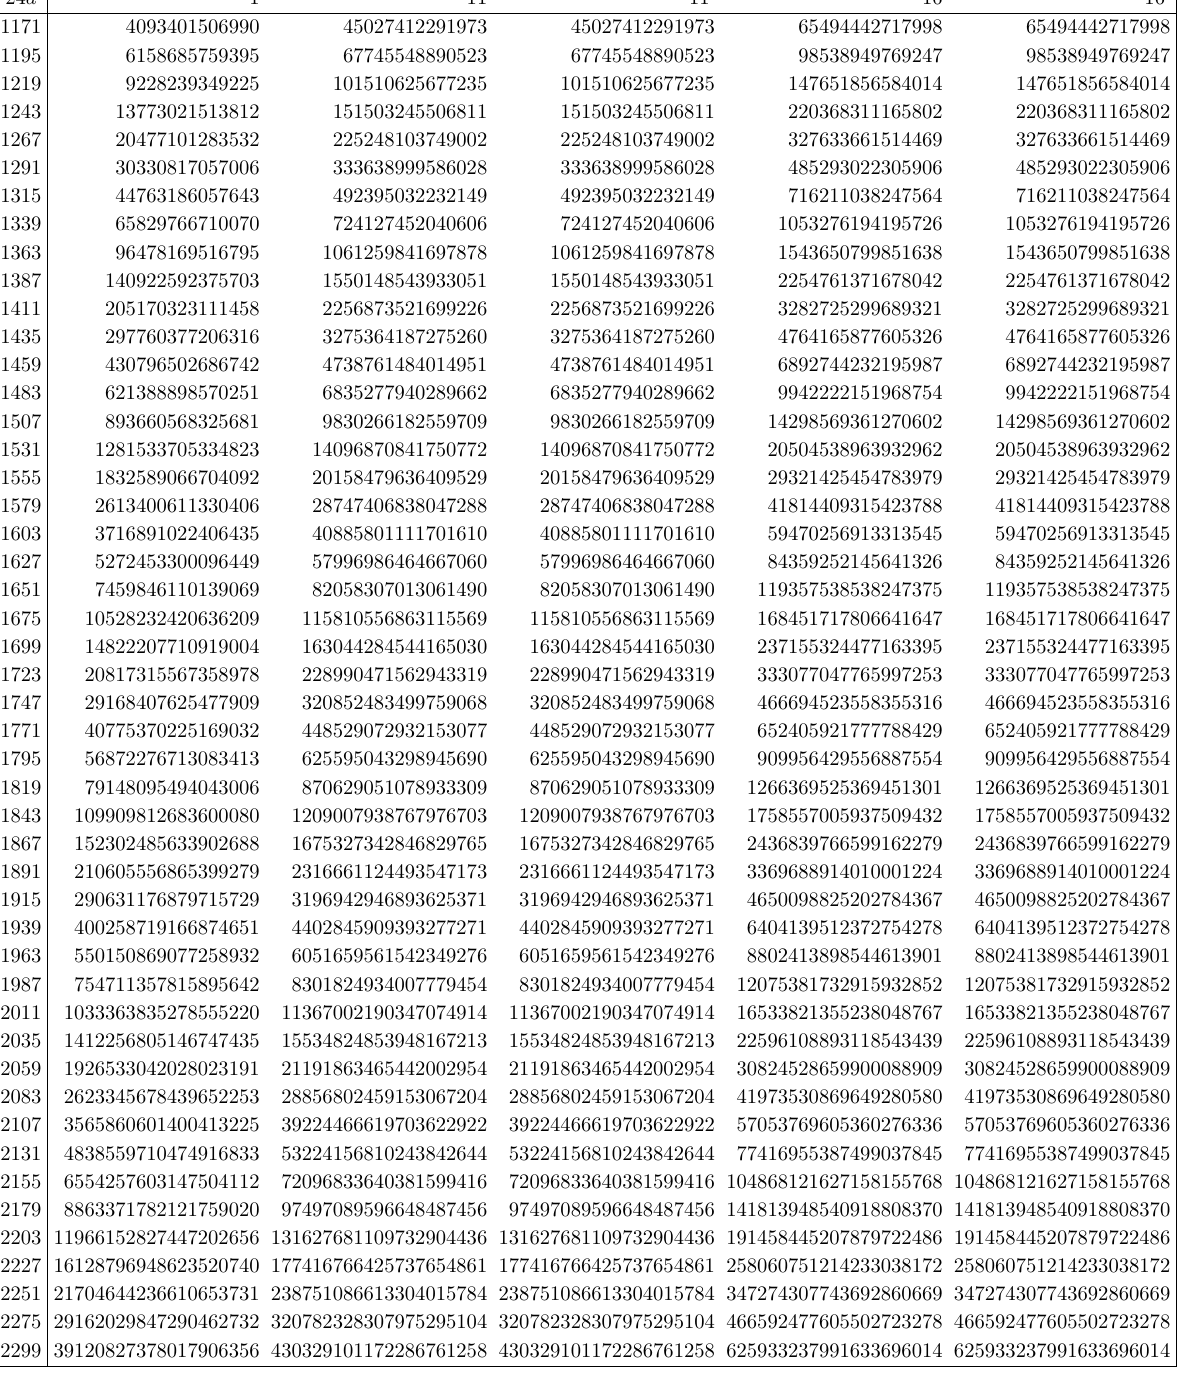
Table 6 . Multiplicity generating functions f (1)